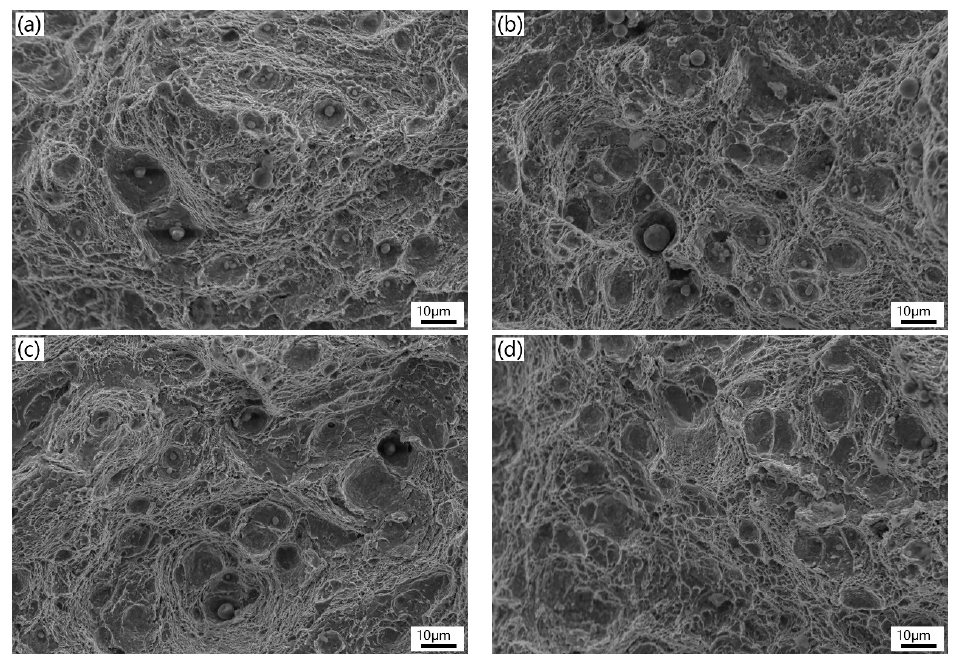
Figure 11. Images of impact fracture morphology: ( a ) 1L (low Si and low temperature), ( b ) 1H (low Si and high temperature), ( c ) 2L (high Si and low temperature), and ( d ) 2H (high Si and high